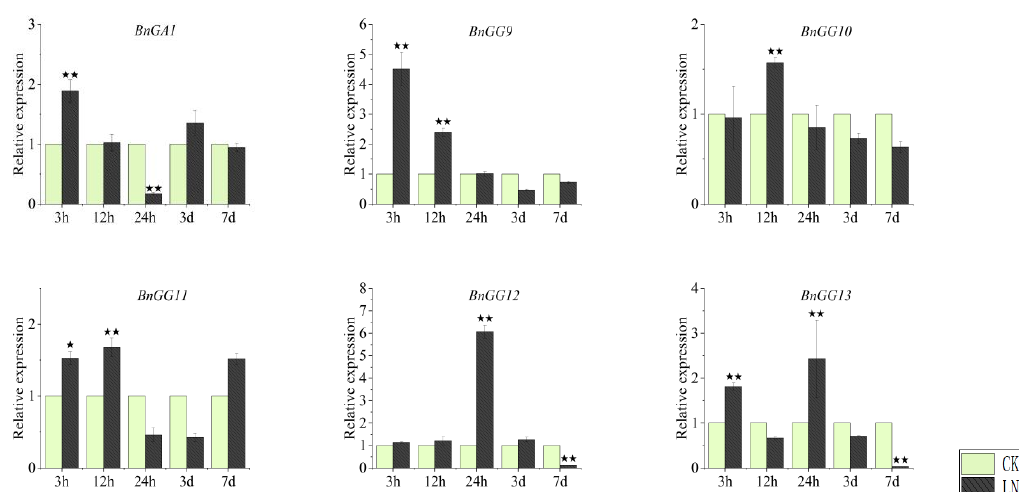
Figure 9. Expression profiles of G-protein genes in roots under normal and nitrogen-deficient con- ditions. Quantitative RT-PCR was used to investigate the expression levels of one G α gene ( BnGA1 ) and five C-type G γ genes ( BnGG9 , BnGG10 , BnGG11 , BnGG12 , and BnGG13 ). Roots were collected under normal-growth and nitrogen-deficient conditions at 0 h, 3 h, 12 h, 24 h, 3 d, and 7 d after treatments. Data were normalized to the BnActin7 gene and vertical bars indicate standard devia- tion. Compared with the expression of G-protein genes in CK condition at each time point, ★ repre- sents the significant level, ★★ represents the extremely significant level.